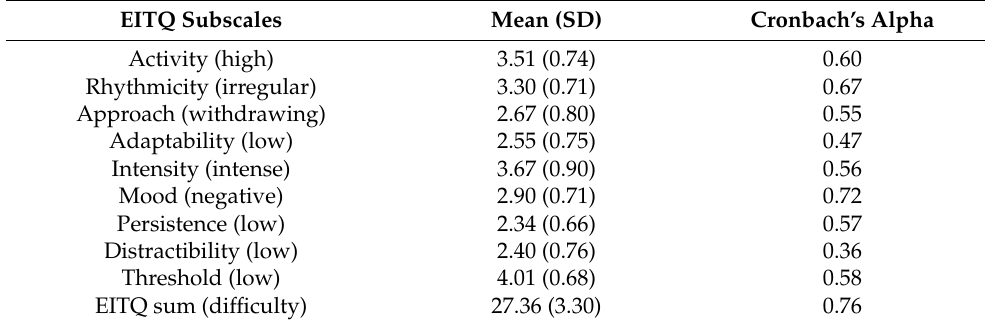
Table 5. Descriptive statistics of EITQ subscales of temperament (N = 43).